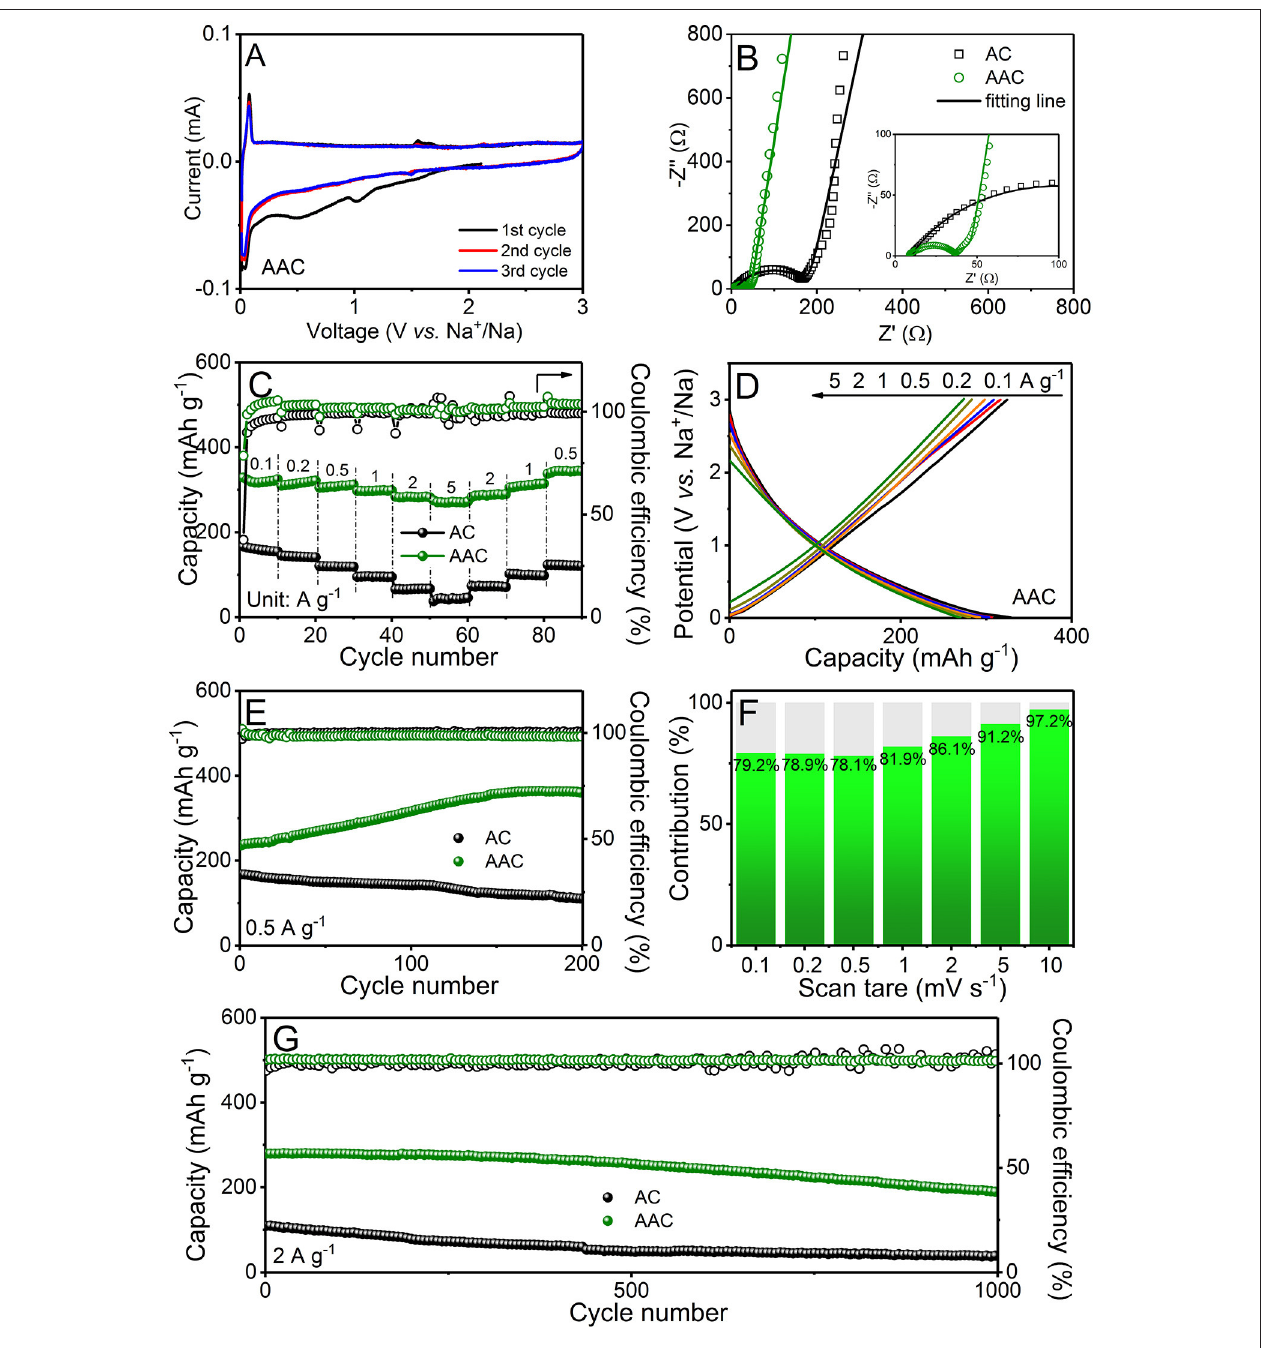
FIGURE 6 | Electrochemical measurements of AAC and AC as anode materials for SIBs: (A) cyclic voltammetry (CV) curves at 0.1mV s − 1 of AAC; (B) electrochemical impedance spectra in form of Nyquist plots of AAC and AC before cycling with detailed view in high frequency area as the inset; (C) rate performances of AAC and AC and (D) charge/discharge curves of AAC at different current densities; (E) long-term cyclic performances at 0.5A g − 1 ; (F) bar chart of pseudocapacitive contribution at various sweep rate; (G) long-term cyclic performances at 2A g − 1 .